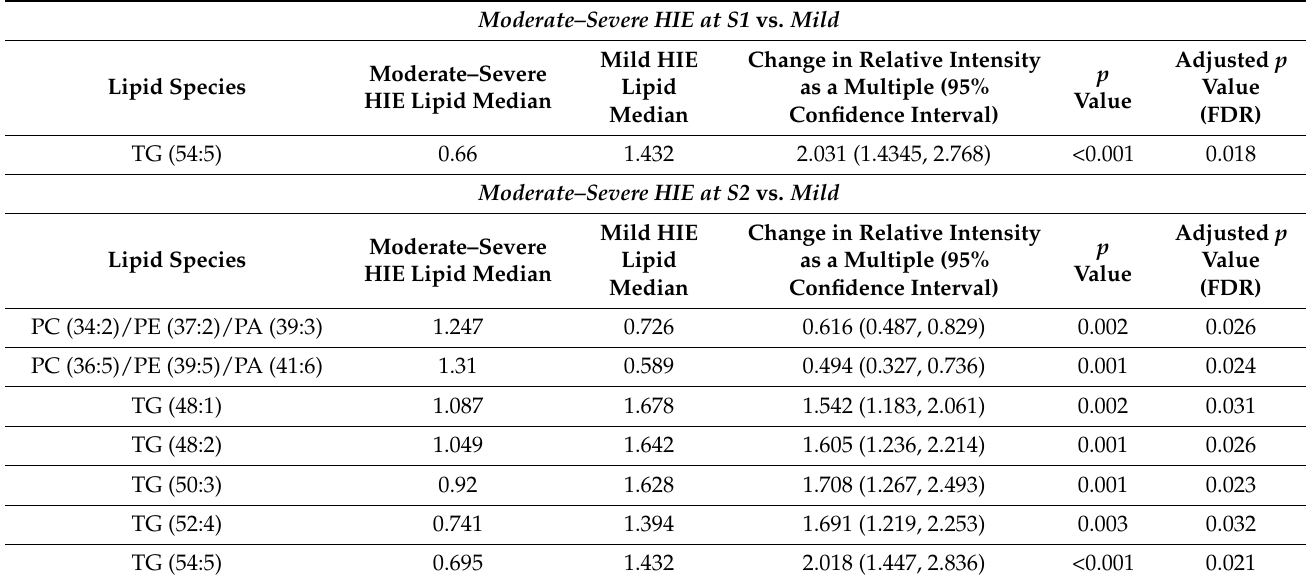
Table 2. Mann–Whitney U test statistics for significant lipid species when comparing Mild vs. Moderate–severe HIE at S1 and S2.